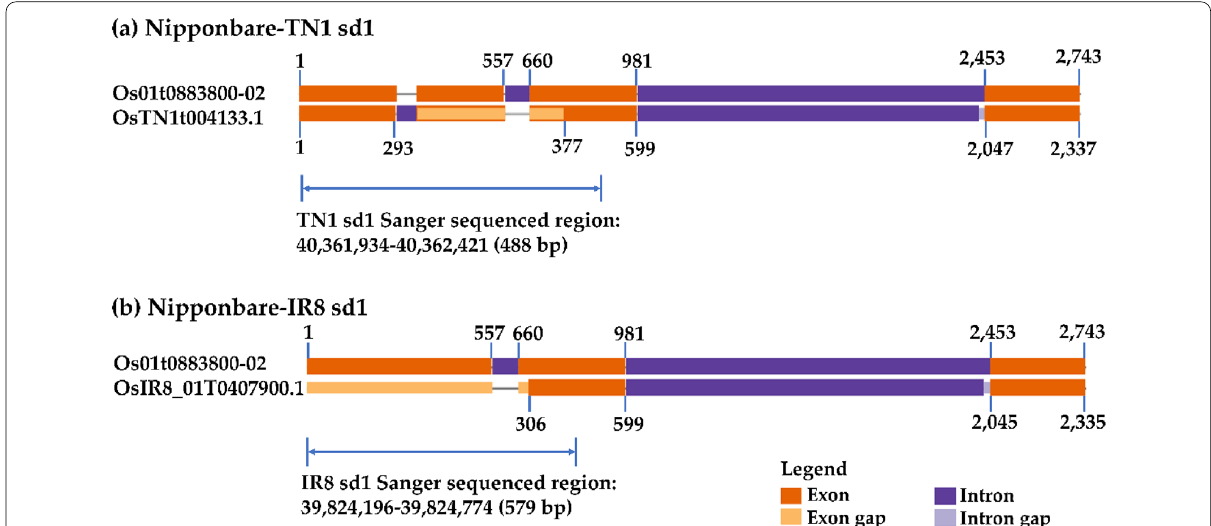
Fig. 2 The sd1 exon to exon gene diagrams of TN1, IR8 and Nipponbare. TN1 (2337 bp), IR8 (2335 bp), and Nipponbare (2,743 bp). a Nipponbare vs TN1 and b Nipponbare vs IR8. Os01t0883800‑02 is from Nipponbare, OsTN1t004133.1 is from TN1, and OsIR8_01T0407900.1 is from IR8. These names are based on the transcript ids of their sd1 gene. Numbers indicate the exon boundaries of the genes. For TN1 position 1 is at 40,361,934 bp, while for IR8 position 1 is at 39,824,196 bp. In Nipponbare, position 1 is at 38,382,466. The gene diagrams were created by GenePainter (Hammesfahr et al. 2013) by using the protein alignments of sd1 and the information from their gff annotation (Nagano et al. 2005; Panibe et al. 2021). The range specified by the light blue arrow represents the sequences of sd1 in TN1 and IR8 that were validated by our Sanger sequencing. The 382 bp deletion in TN1 can be derived by computing the difference between 981 and 599, the latter of which represents the gene length of TN1 sd1 before its